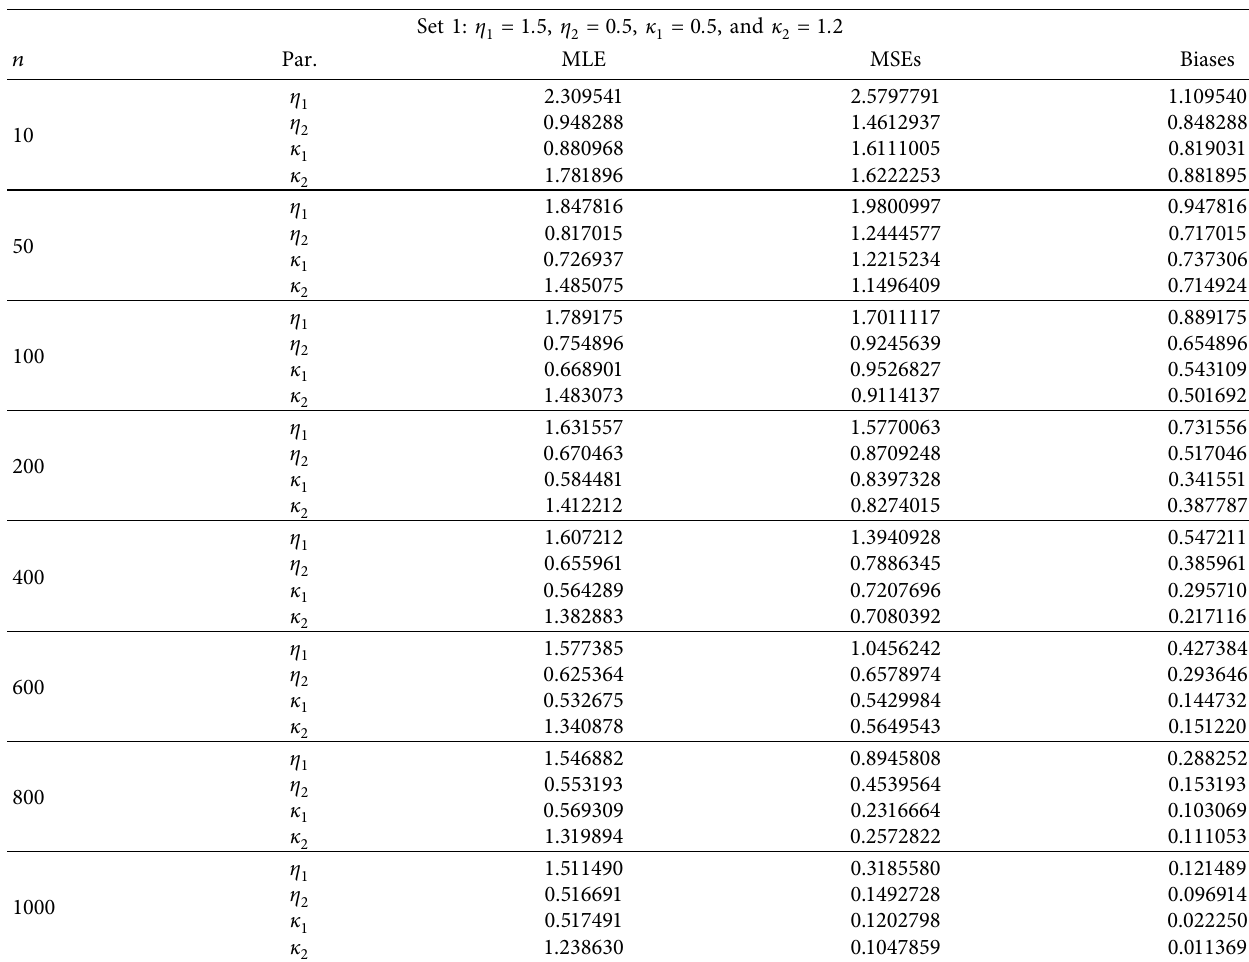
Table 1: Simulation results of the ASNFEW distribution for the first set of parameter values.